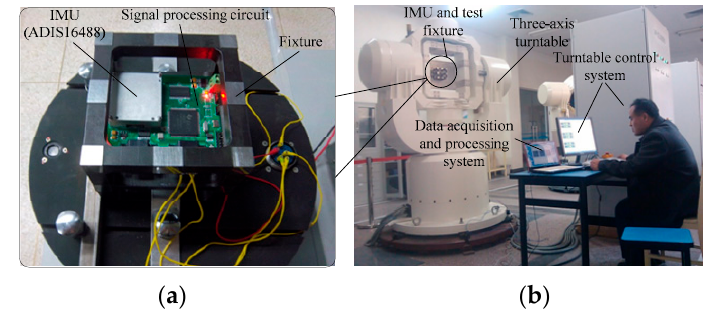
Figure 2. Experimental system. ( a ) Inertial measurement unit (IMU) and fixture. ( b ) Integral structure.